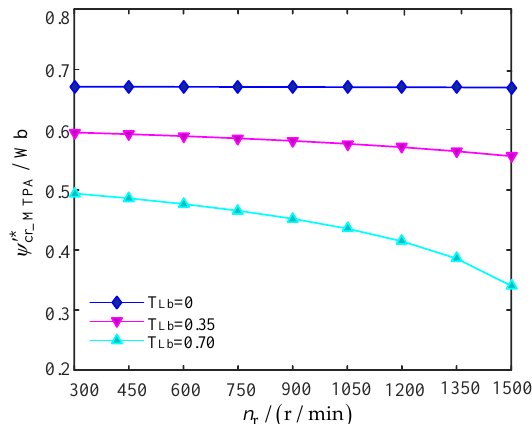
∗ Figure 5.   ψ is computed when the torque changes. Figure 5. ψ ’ is computed when the torque changes. cr_MTPA Figure 5.   ψ is computed when the torque changes. cr_MTPA cr_MTPA